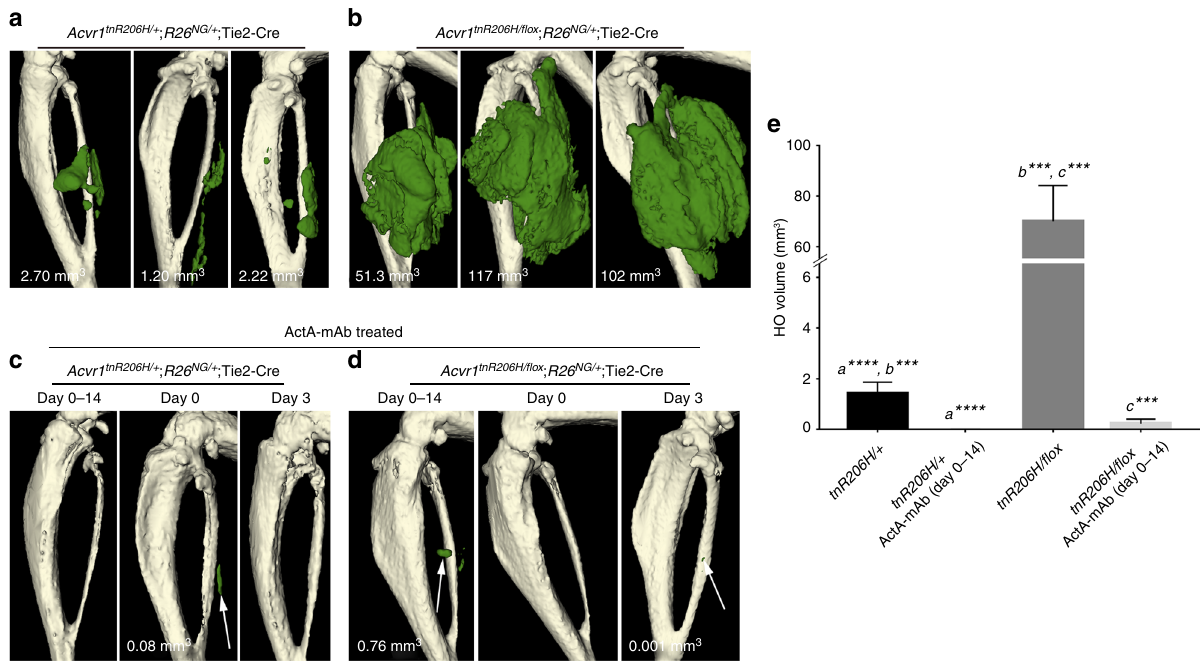
Fig. 6 HO is greatly exacerbated by loss of wild-type Acvr1 . a , b Representative µ CT images of HO (pseudocolored green) 14 days after pinch injury of the gastrocnemius muscle of Acvr1 tnR206H/ + ; R26 NG/ + ;Tie2-Cre ( a ; n = 7) or Acvr1 tnR206H/ fl ox ; R26 NG/ + ;Tie2-Cre ( b ; n = 8) mice. c , d ActA-mAb administered at 10 mg/kg in both mouse genetic models, either twice weekly beginning at the time of injury (Day 0 – 14; tnR206H/+, n = 12; tnR206H/ fl ox, n = 7), as a single dose at the time of injury (Day 0; tnR206H/+, n = 8; tnR206H/ fl ox, n = 4), or as a single dose 3 days post-injury (Day 3; tnR206H/+, n = 12; tnR206H/ fl ox, n = 4), was highly effective at inhibiting HO. Residual HO in these treated mice is shown at arrows. HO volume (mm 3 ) in a – d is given. e Quanti fi cation of HO volume at day 14 post-injury from untreated and ActA-mAb-treated mice. Bars represent ± SEM. *** p < 0.001, **** p <